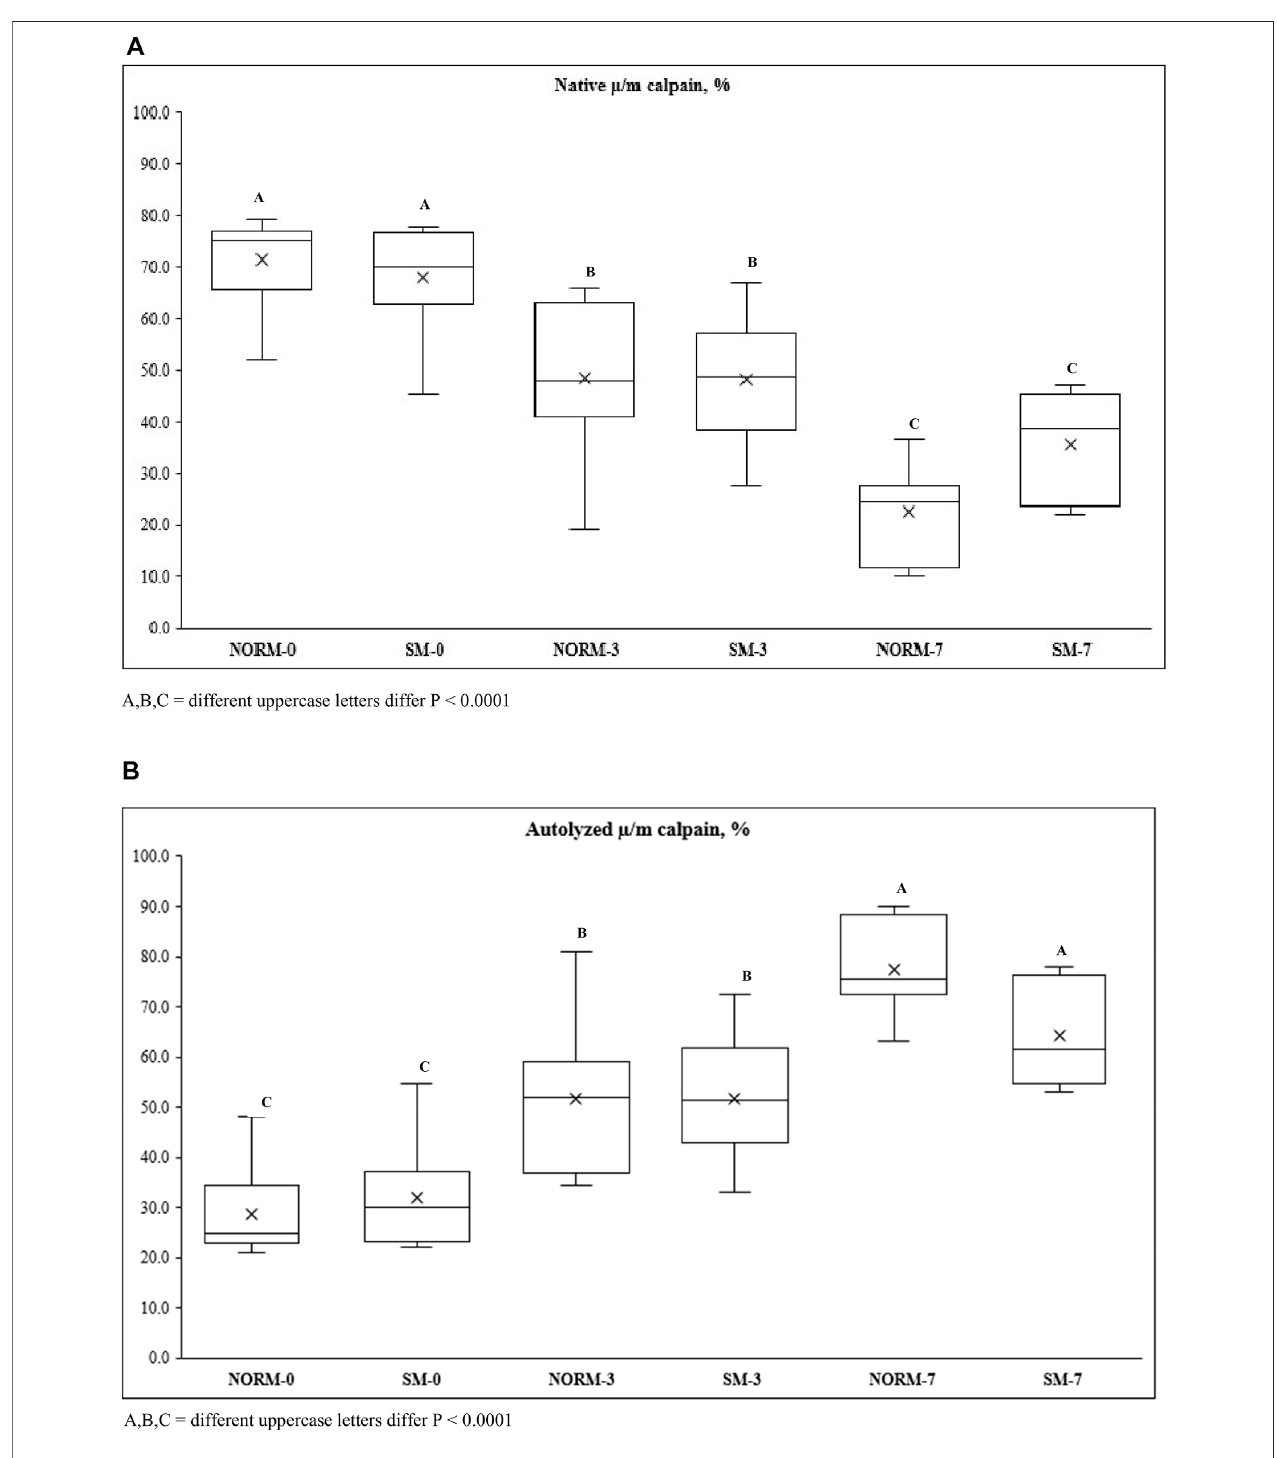
FIGURE 4 | Native µ/m (A) and autolyzed µ/m (B) calpain activity of broiler breast meat according to the interaction M × T between muscle condition (M — normal, NORM; Spaghetti Meat, SM) and postmortem time (T — 0, 3, 7 days).